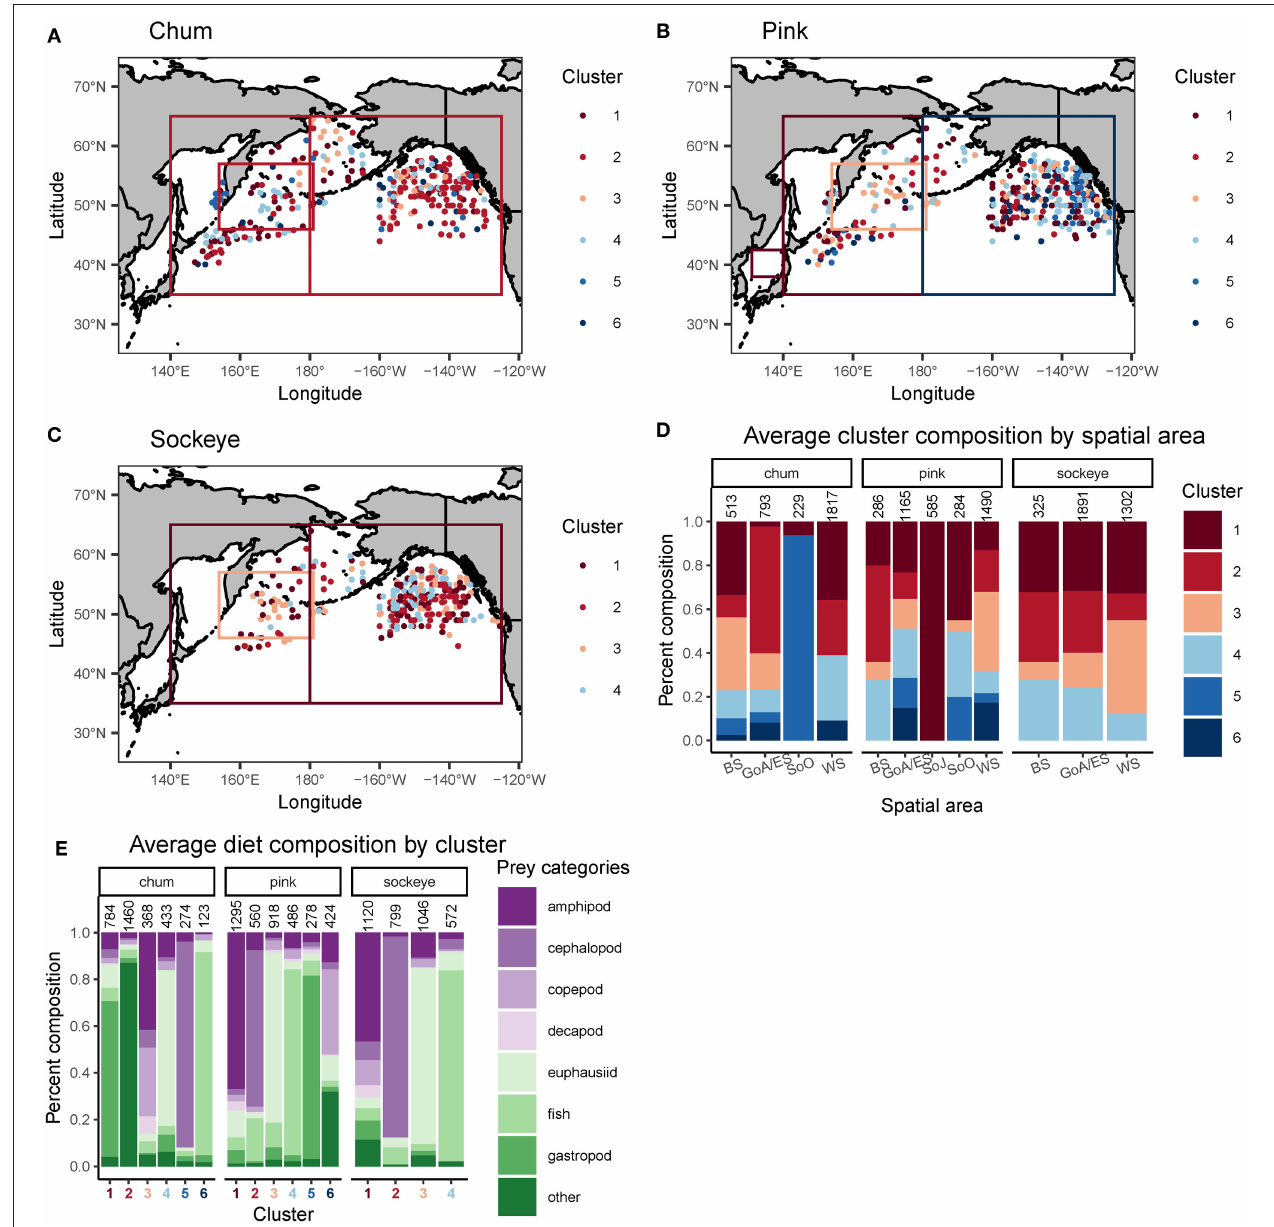
FIGURE 4 | Spatial representation of a cluster analysis performed on Bray-Curtis dissimilarities between arcsine square root transformed proportional weight/volume diet data of (A) chum, (B) sockeye and (C) pink salmon. The boxes on the maps in (A–C) represent one data point reported for an entire area, as opposed to data points with precise spatial coordinates. Ward’s clustering method was performed separately for each salmon species. Silhouette coefficients and plots were used to determine the number of clusters. The proportional cluster composition for each species and spatial area (BS, Bering Sea; GoA/ES, Gulf of Alaska/Eastern Subarctic; SoJ, Sea of Japan; SoO, Sea of Okhotsk; WS, Western Subarctic) is displayed (D) with known samples sizes (total number of salmon) above each bar. The average proportional diet composition of each cluster and species is displayed (E) with known sample sizes above each bar. The sample sizes displayed are an underestimate of the actual sample sizes since these values were not always reported in the source.